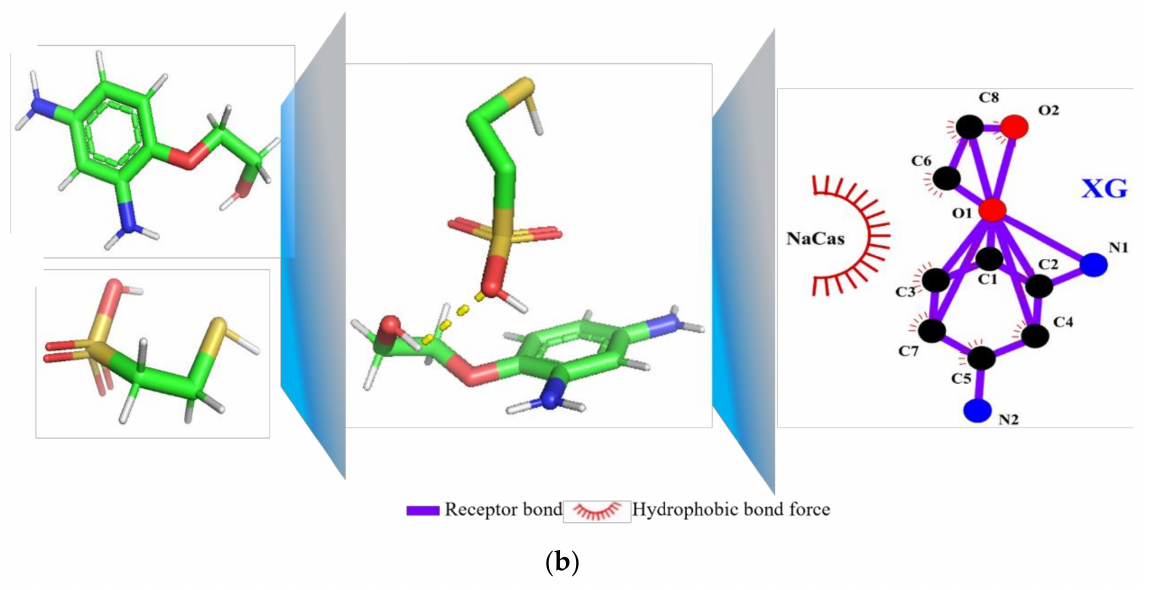
Figure 6. Molecular docking technique of NaCas and XG. ( a ) receptor-NaCas, ligand-XG; ( b ) receptor- XG,